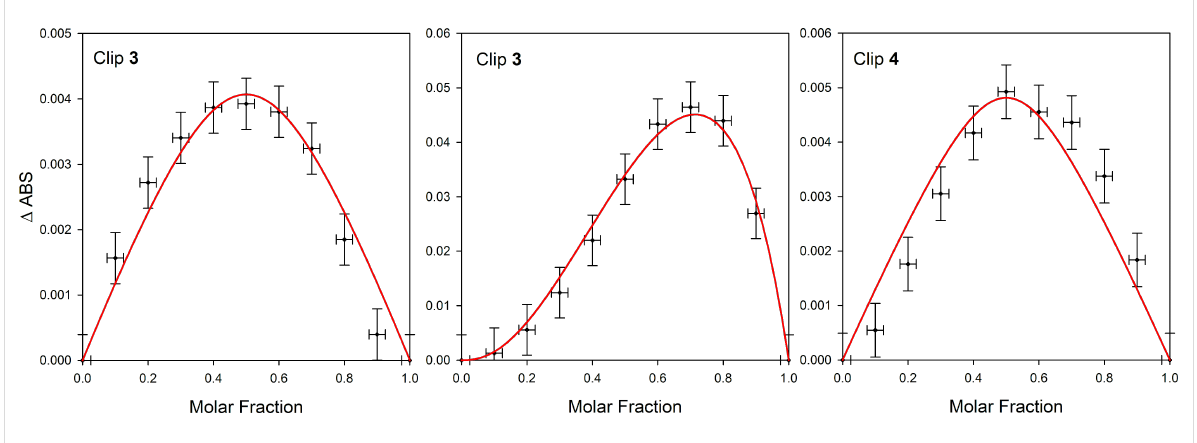
Figure 9: Left: Job plot analysis for DNB vs molecular clip 3 ([ 3 + DNB] = 10 − 3 M in o -C 6 H 4 Cl 2 at 800 nm) at room temperature. Middle: Job plot for F 4 -TCNQ vs molecular clip 3 at room temperature ([ 3 + F 4 -TCNQ] = 10 − 5 M in CH 2 Cl 2 at 860 nm) consistent with a 2:1 binding stoichiometry. Right: Job plot for F 4 -TCNQ vs molecular clip 4 at room temperature ([ 4 + F 4 -TCNQ] = 10 − 5 M in CH 2 Cl 2 at 860 nm) in agreement with a 1:1 binding stoichiometry.